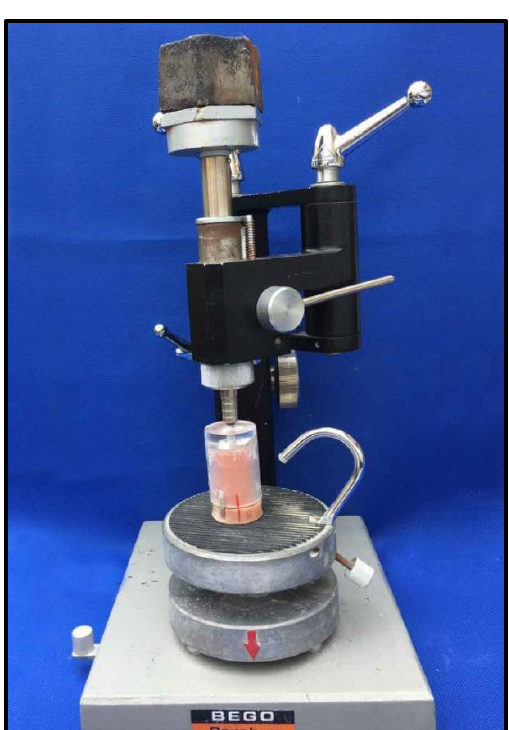
Figure2: Impression taking with the dental